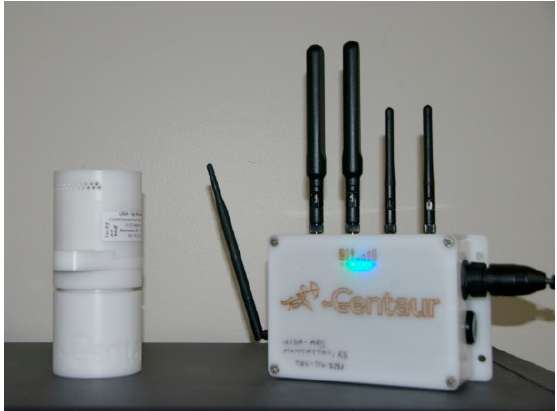
Figure 1. Photograph of the wireless sensor on the left and communication electronics on the right.